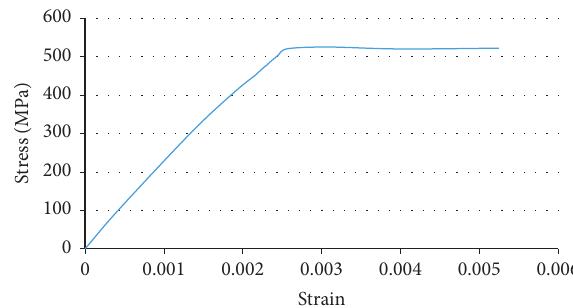
Figure 6: Tensile stress-strain curve of steel